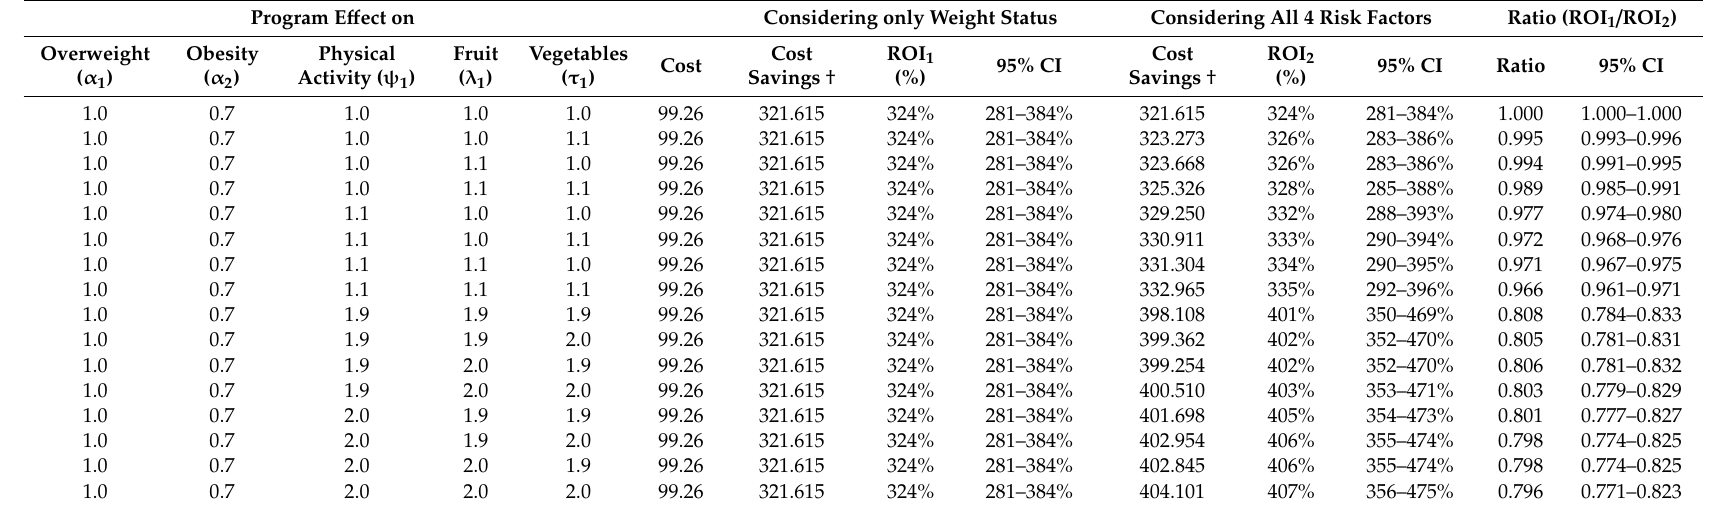
Table 4. Estimated return on investment, considering e ff ects on all four risk factors compared to weight status